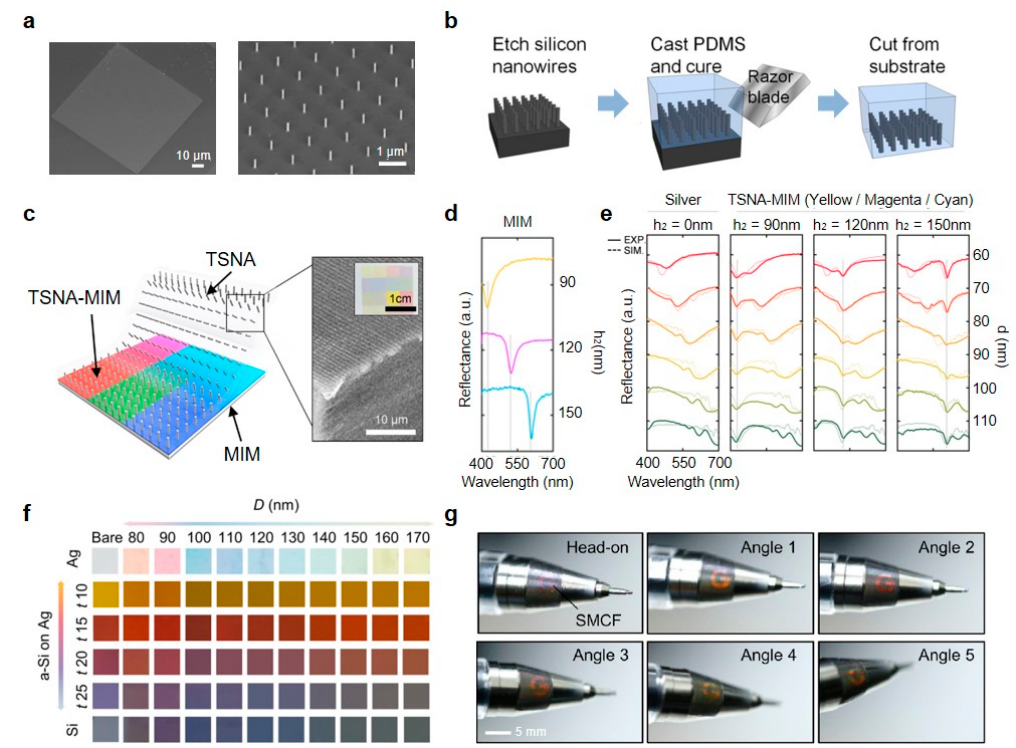
Figure 6. ( a ) SEM images of the square array of vertical nanowires. Top-view (left) and 30 ◦ of tilt-view (right). ( b ) Schematic of the transferring process of Si nanowires into the PDMS substrate. ( c ) Schematic of transferable Si NWAs onto MIM (TSNA-MIM), TSNA and MIM configurations. ( d ) Measured reflectance spectra for MIM for yellow, magenta and cyan colors, respectively. ( e ) Reflectance spectra of TSNA on colored MIMs. ( f ) The color table with the photographs of the integrated spectral mixing color filter (SMCF) according to the thickness and diameter of a-Si and Si nanowire array, respectively. ( g ) Photographs of SMCF-based anti-counterfeiting sticker with a variety of viewing angles. ( a ) Reprinted with permission from [37]. Copyright 2011 American Chemical Society; ( b ) reprinted from [112], with the permission of AIP Publishing; ( c – e ) reprinted with permission from [113]. Copyright 2019 American Chemical Society; ( f , g ) reprinted by permission from Springer Nature: Springer Scientific Reports [61], Copyright 2019.